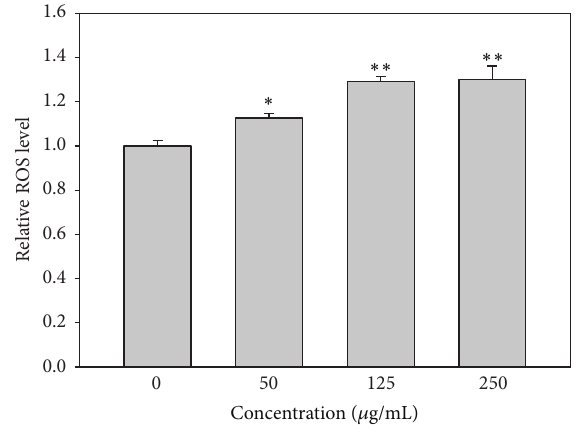
Figure 2: ROS generation of IS-treated HUVECs. Quantification analysis of relative ROS mean intensity of DCFH-DA (% of control). Cells were treated with 0, 50, 125, and 250 𝜇 g/mL of IS for 24 h. Data, mean ± SD ( 𝑛 = 3 ). ∗ 𝑃 < 0.01 ; ∗∗ 𝑃 < 0.001 compared to the control.